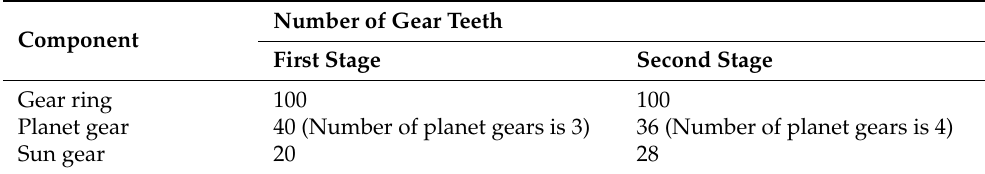
Table 2. The number of gear teeth in the planetary gearbox.